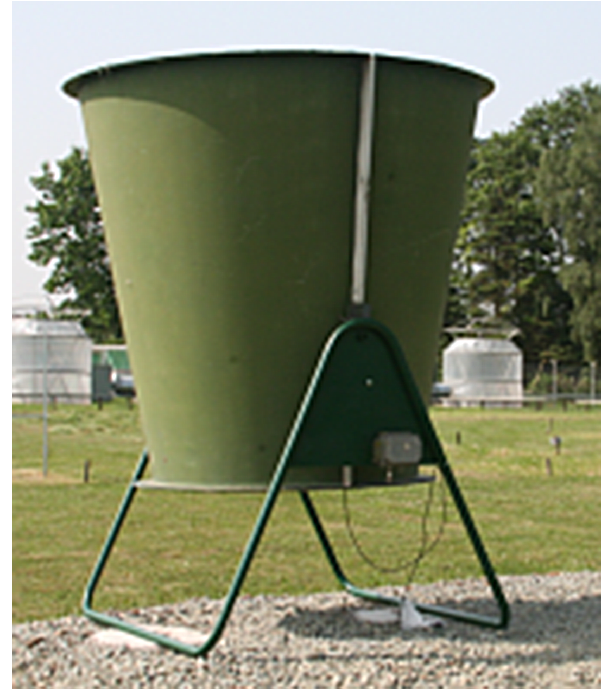
Figure 37. Vertical SODAR ECHO-1 at the Marburg Ground Truth and Profiling Station, Marburg University,